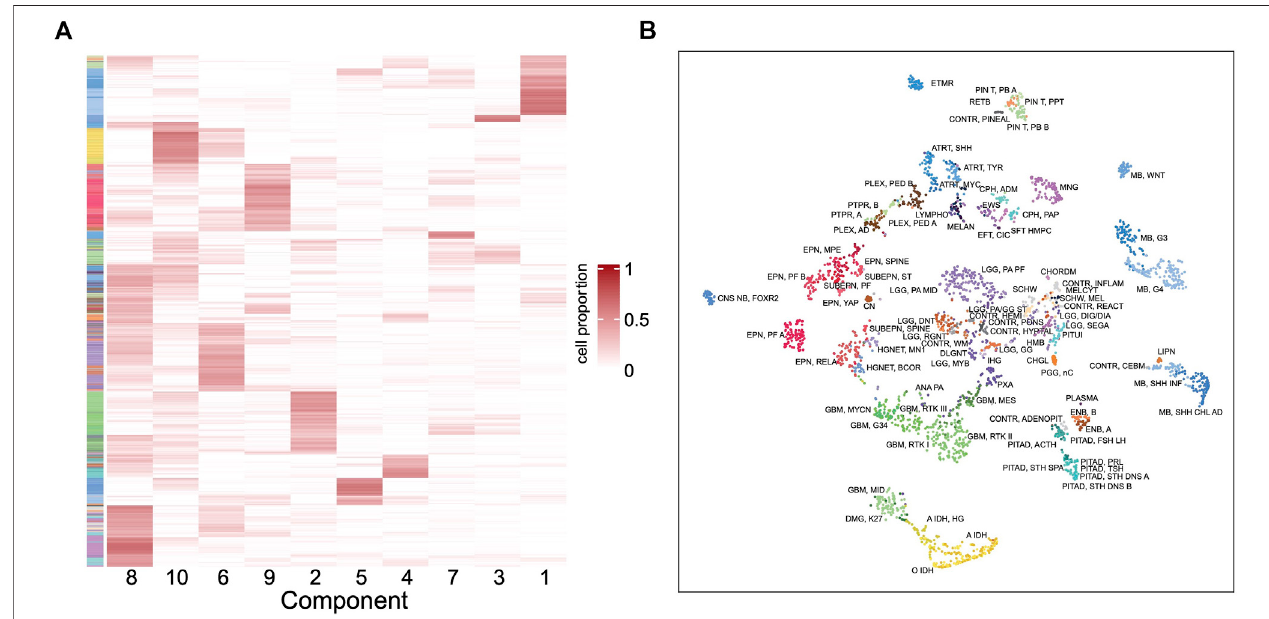
FIGURE 6 | Deconvolution result in the training set. (A) Heatmap of the cellular proportions of 10 components in all the samples. Rows are samples and columns are the components. (B) The t -SNE dimensionality reduction result based on the proportions of 10